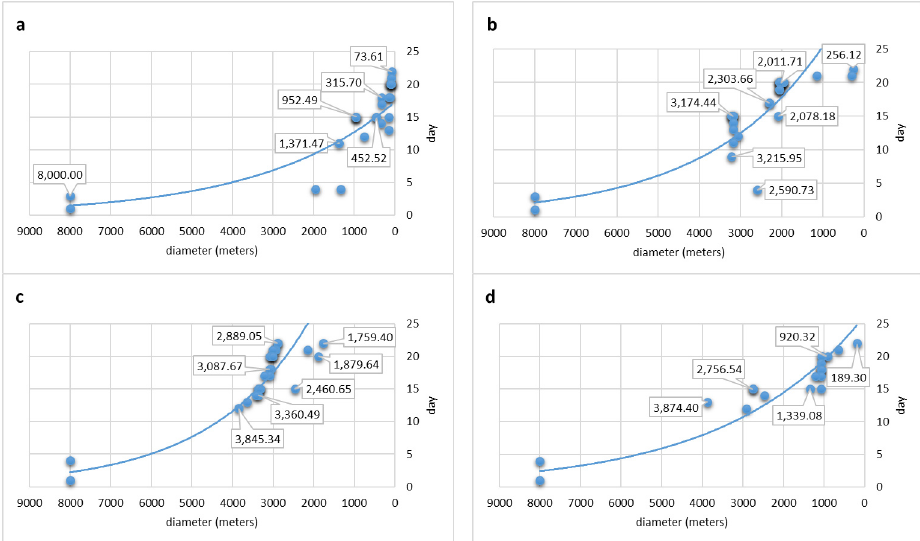
Figure 3. Spatiotemporal evolution of the geo-consensus on questions 1 ( a ); 2 ( b ); 3 ( c ) and 4 ( d ). Location of places for installation of mobile blood-collection units.